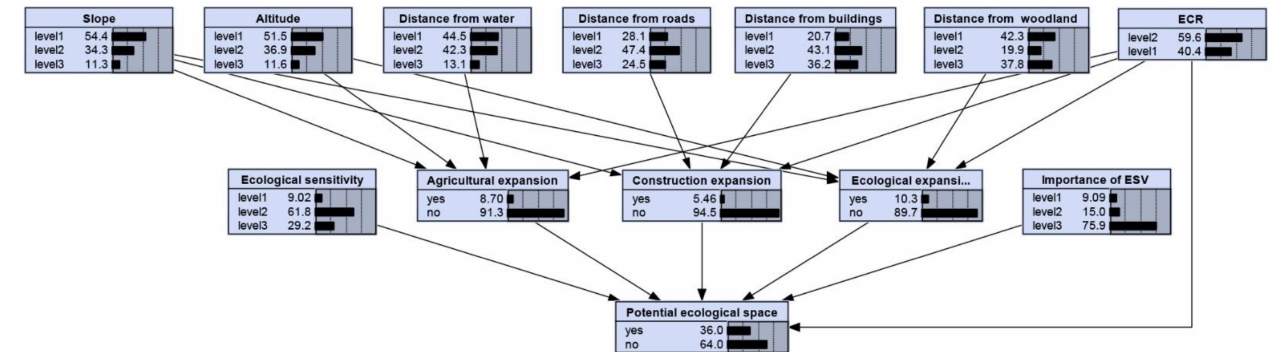
Figure 7. Training result of BN